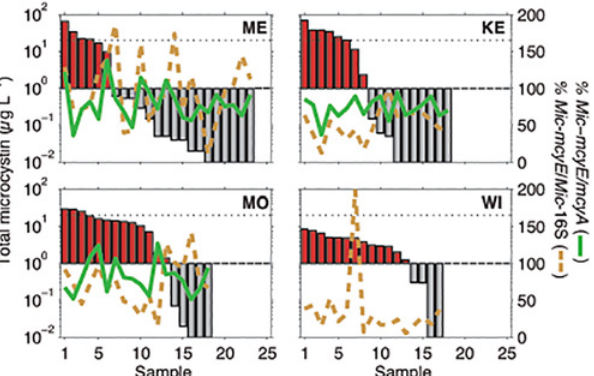
Fig 4. Comparison of percent Microcystis - mcyE / mcyA and percent Microcystis - mcy / Microcystis -16S versus the concentration of total microcystin observed (bars). For correlation coefficients, refer to the text or S2 – S5 Tables. The black dashed line is the World Health Organization (WHO) level for safe drinking water (1 μ g L -1 ), while the dotted line is the WHO level for moderate recreational risk (40 μ g L -1 ). Note that Lake Wingra had the most detects above 1 μ g L -1 , despite having the lowest concentrations of Total MC and percent toxic Microcystis